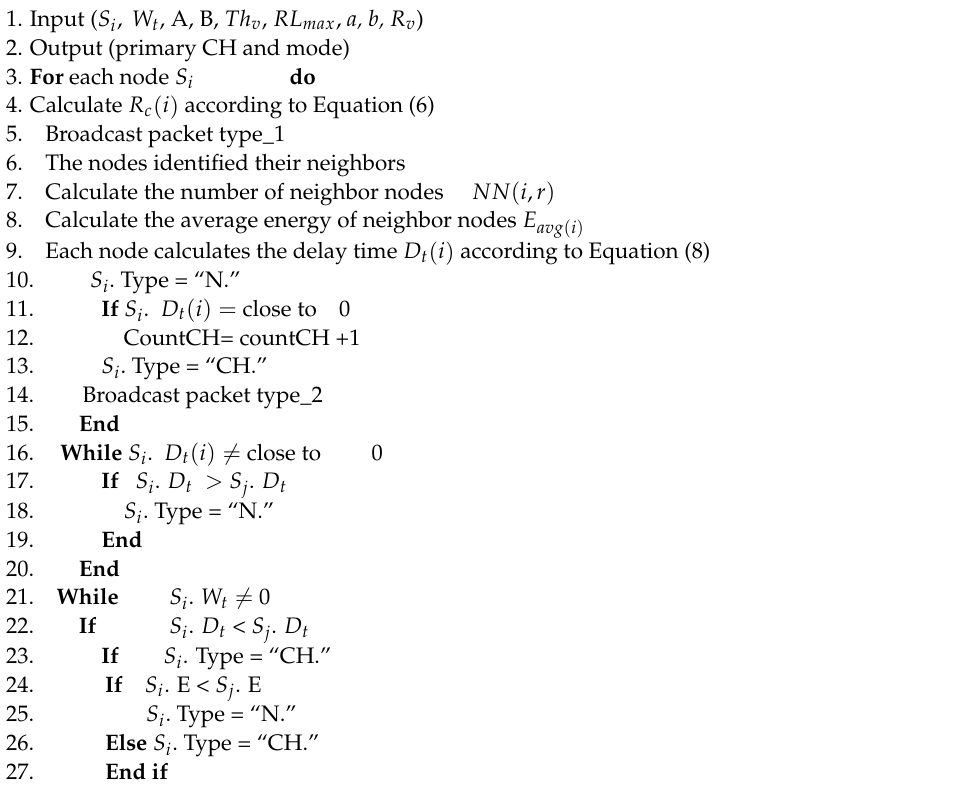
Algorithm 2 Primary CH Selection and Sleep Awake